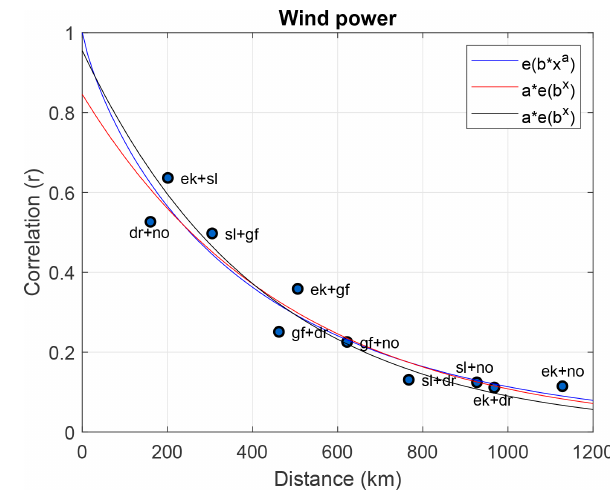
Figure 4. How the correlation between site pairs changes with distance, including three exponential curves giving the best least- squares fit for the 10 correlation